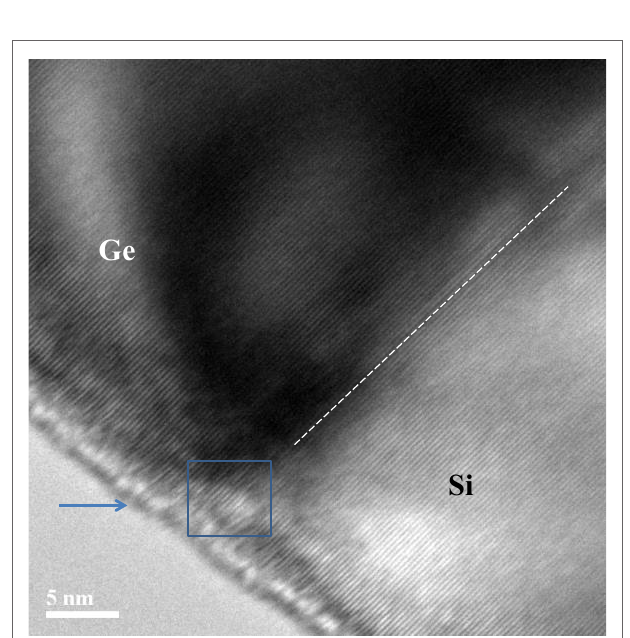
FiGURe 5 | High-resolution TeM image of the Si/Ge Nw HJ interface close to the Nw surface with clearly observed distortion of the lattice fringes (see box) . An amorphous layer of ~ 1 nm thickness at the NW surface is indicated by an arrow (Wang et al.,